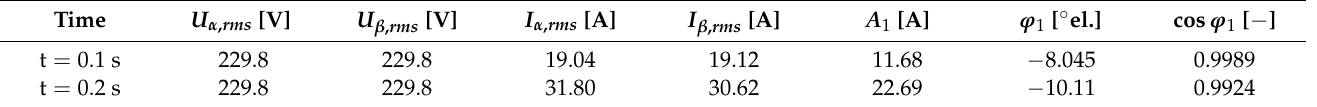
Table 17. Simulation results before and after the change (at steady states).